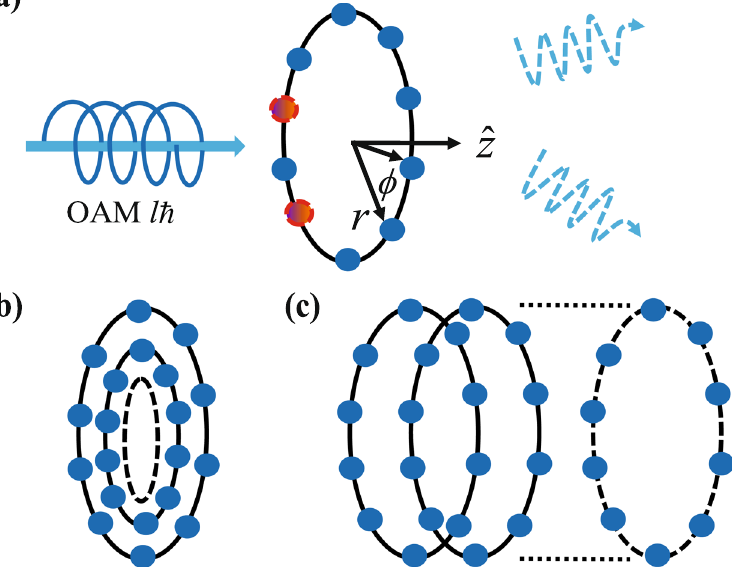
Figure 1. Schematic helical-phase-imprinted multiphoton state preparation. ( a ) A multiphoton source carrying orbital angular momentum (OAM) is absorbed by the atoms on a single ring, where two excitations (dash circles) are shown here for demonstration and as one possibility out of the complete excitation space. The atomic system is then prepared into one of multiphoton super- or subradiant states, depending on OAM lħ ; of light. The scattered light property out of these multiphoton states depends on the ring geometry of radius r and φ . Other atomic configurations of ( b ) concentric or ( c ) stacked rings can be the candidates for creation of helical-phase- imprinted multiphoton